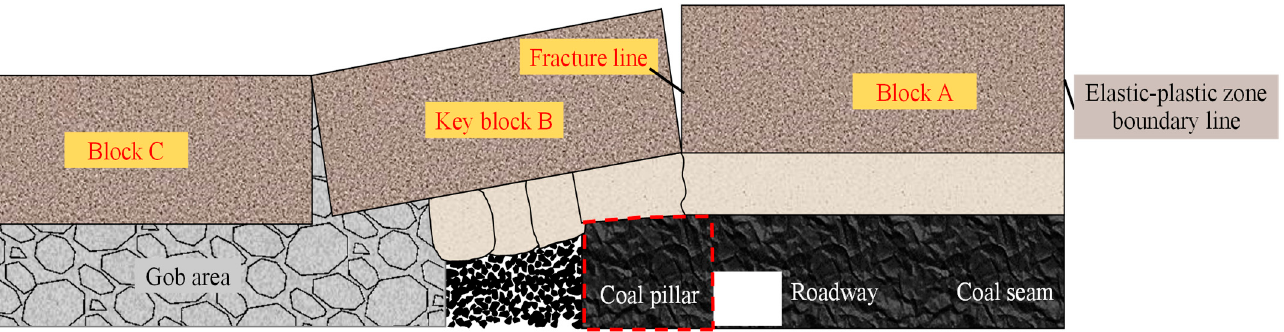
Figure 17. Structure model with main roof fracture line above the coal pillar [53].